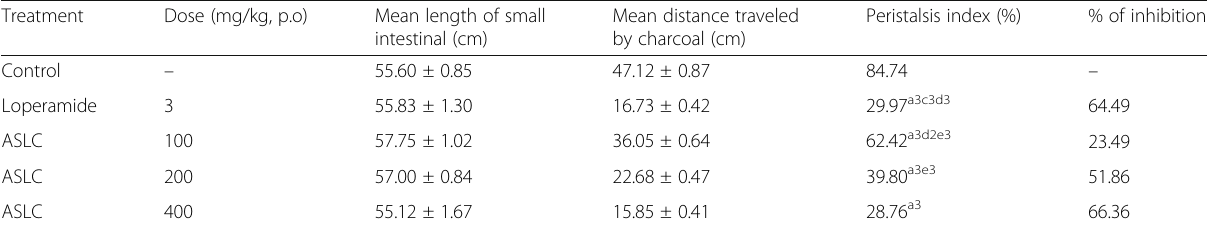
Table 4 Effect of the aqueous stem extract of L. camara on castor oil induced gastrointestinal transit in mice Treatment Dose (mg/kg, p.o)